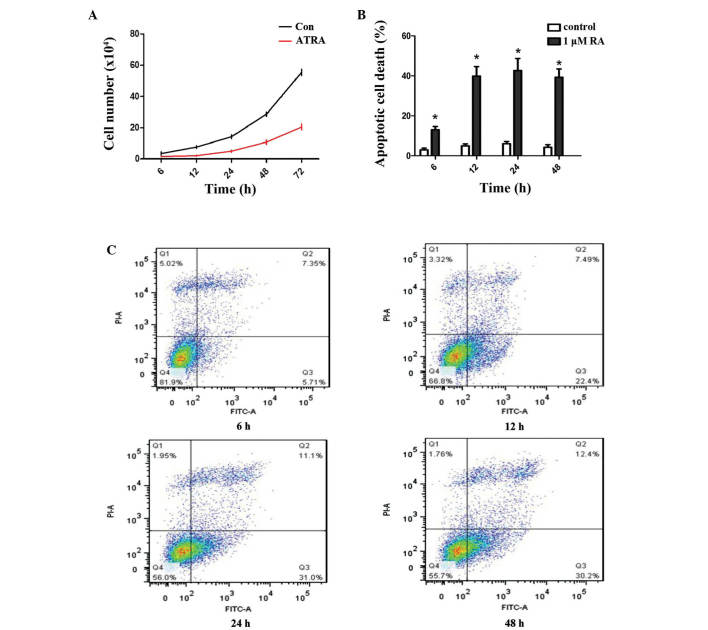
ATRA induces apoptotic cell death of chondrogenic competent cells. rEHBMCs were cultured with or without 1 μM ATRA. (A) Number of cells was counted at the indicated time-points. (B) Percentages of apoptotic cells were quantified by flow cytometric analysis following 6, 12, 24 and 48 h of culture. Values are expressed as the mean ± standard deviation of three independent experiments. *P<0.01, compared with control cells. (C) Flow cytometric dot plots at the indicated time-points with Annexin V-FITC and PI double staining for the assessment of the apoptotic rate. ATRA, all-trans-retinoic acid; rEHBMCs, rat embryo hindlimb bud mesenchymal cells; FITC, fluorescein isothiocyanate; PI, propidium iodide.